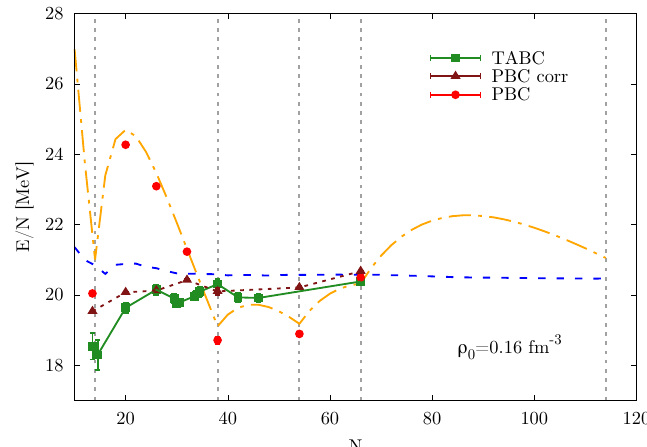
Figure 1. Pure neutron matter (PNM) energy results for the AV8 (cid:48) +UIX potential at saturation density using periodic boundary conditions (PBC) (red cirles) and twist-averaged boundary conditions (TABC) (green squares). Brown triangles are the results for PBC corrected for the Fermi gas (FG) kinetic energy (see text for details). Green solid and brown dotted lines connecting the TABC and PBC corrected results are just a guide to the eye. The FG solutions re-scaled to the interacting system are shown as orange dotted-dashed lines for PBC and as blue dashed lines for